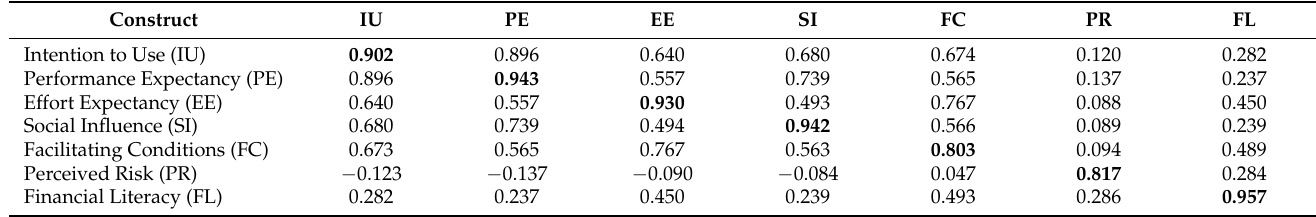
Table A4. Divergent